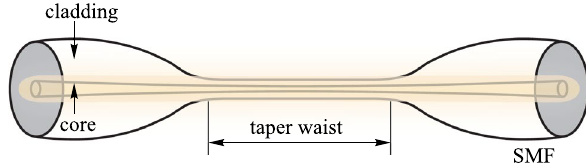
Fig. 10 Schematic diagram of a tapered fiber